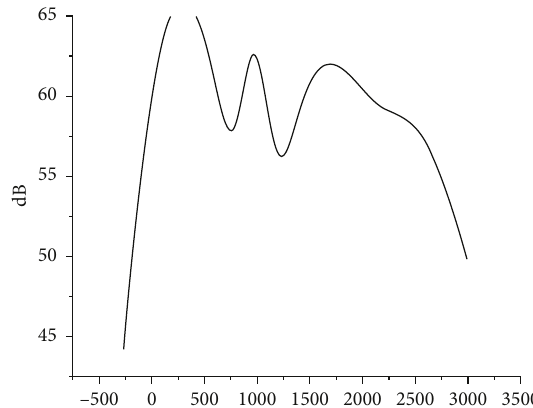
Figure 3: Floor spreading curve of an ordinary residential com- munity (finely decorated